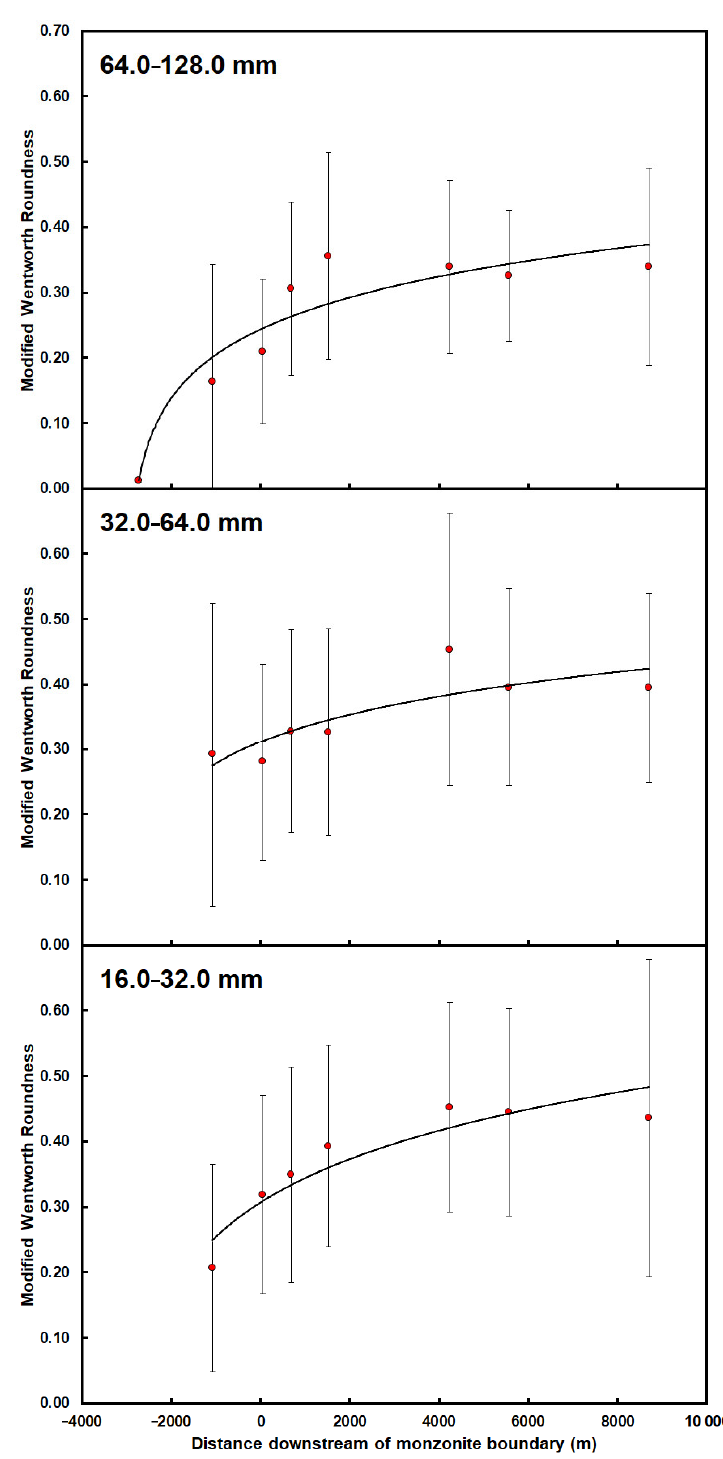
Figure 3. The mean Modified Wentworth Roundness of gravels of Navilawa Monzonite as a function of distance downstream of the boundary of the monzonite intrusion in the Sabeto River of western Viti Levu, Fiji. The data points are expressed with an uncertainty of ± 1 s . The regression lines represent the results of the application of a semi-logarithmic model to the data using least-squares regression. The coefficients of determination ( r 2 ) associated with each model are as follows: 16.0–32.0 mm = 0.862, 32.0–64.0 mm = 0.693, 64.0–128.0 mm = 0.887.